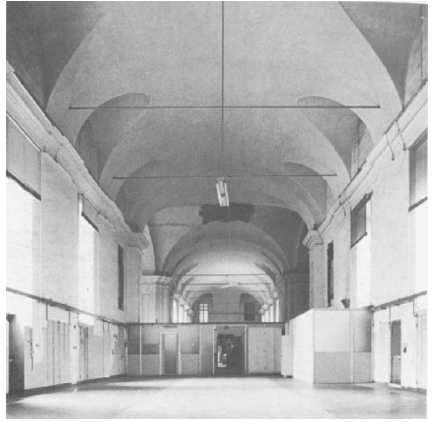
Figure 7. Hospital San Giovanni: photograph inside the vault.